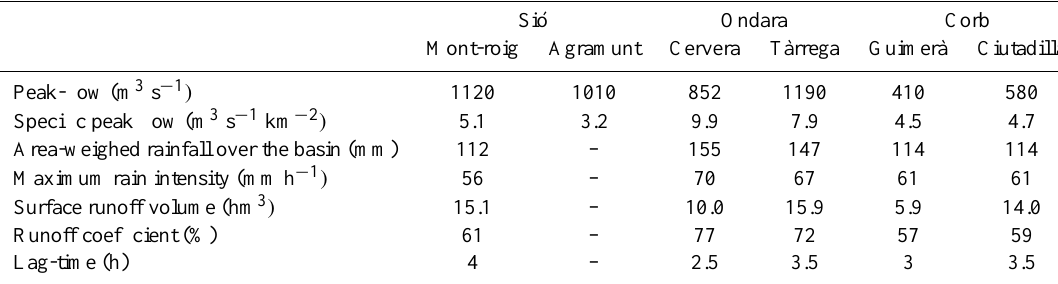
Table 3. Results of the hydraulic and the hydrological modelling.